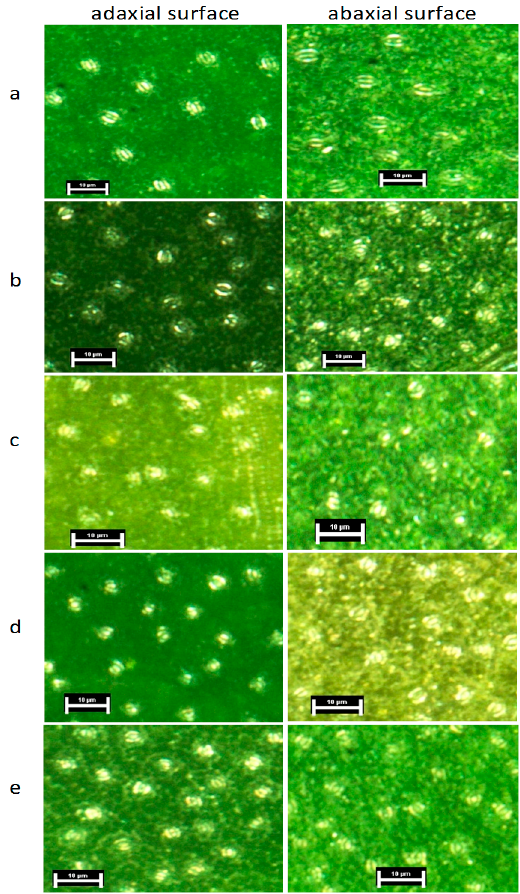
Figure 4. Stomata on the abaxial and adaxial leaf surfaces of 12-week-old Senegalia senegal seedlings. NB1 ( a ), K4B19 ( b ), K17B19 ( c ), DB14 ( d ), DB16 ( e ).